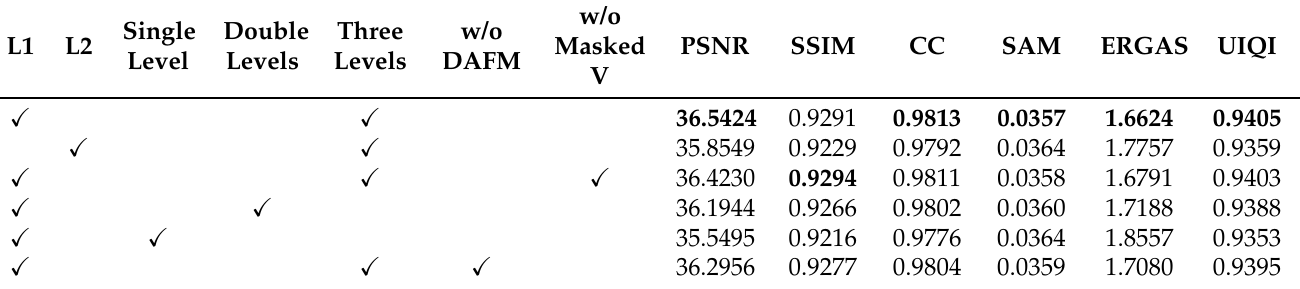
Table 6. Ablation study of the proposed method with different structures on the QB dataset. The best performance is shown in bold.